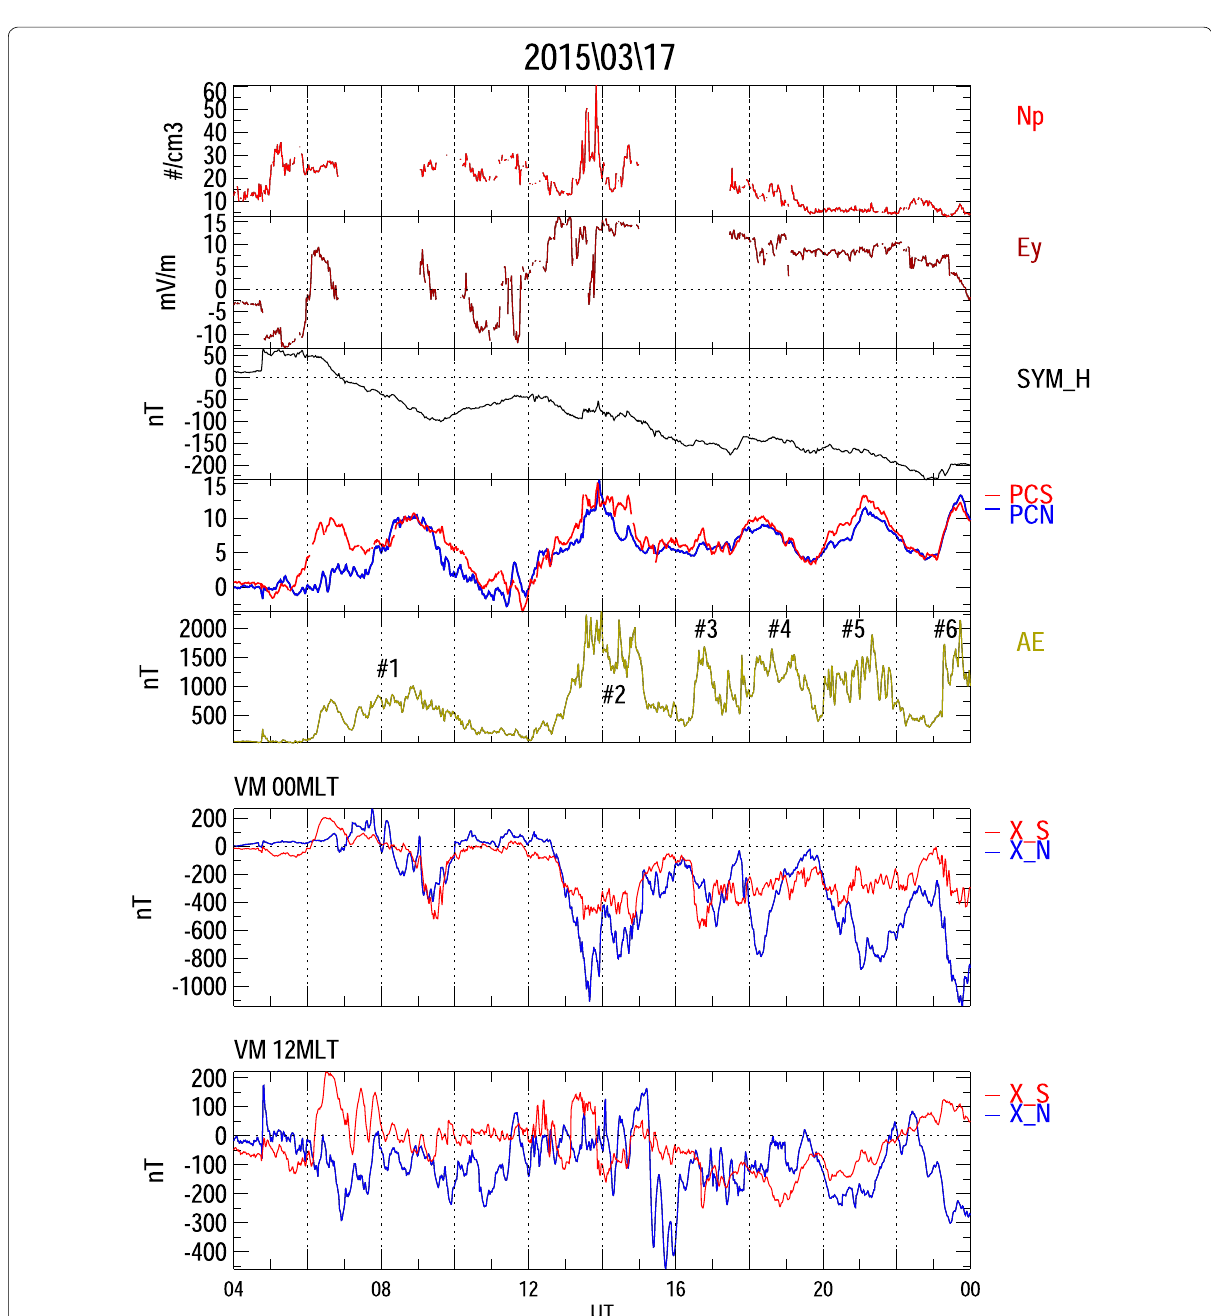
Fig. 2 The space weather parameters during the storm main phase 04–24 UT, March 17, 2015: the solar wind density Np and electric field Ey , SYM-H index, PCN/PCS indices, and AE index. Two bottom panels show the midnight (MLT of geomagnetic response for the Northern (blue line) and Southern (red line) hemispheres. Substorm activations are marked by numbers